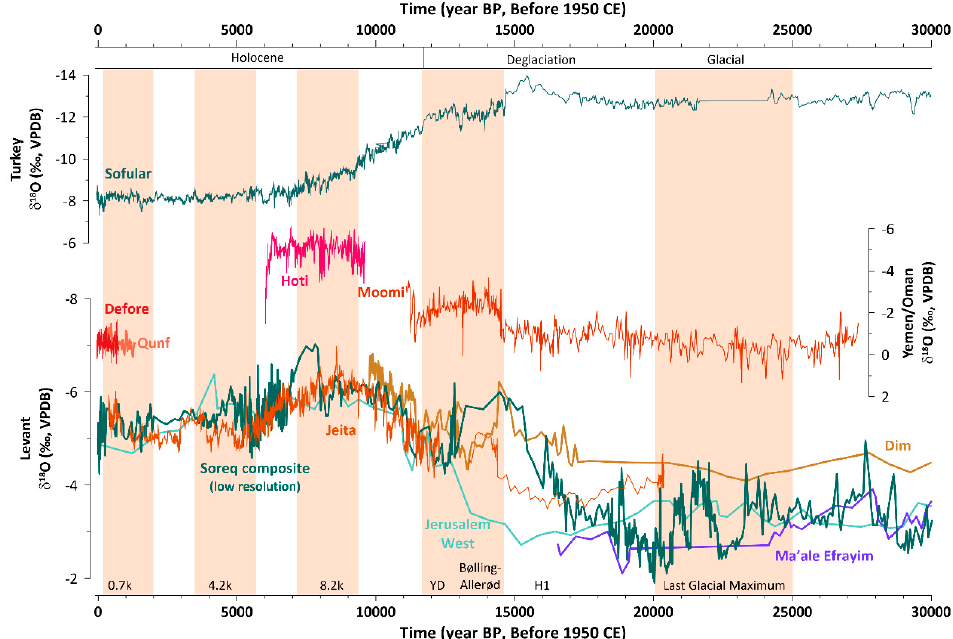
Figure 4. Time-series of δ 18 Occ of speleothem records from the AP (Yemen/Oman), Levant including Turkeys’ Mediterranean coast, i.e., Dim Cave) and Northern Turkey (Sofular). The climatic events highlighted on the plot are based on the interpretations from references [30,131].